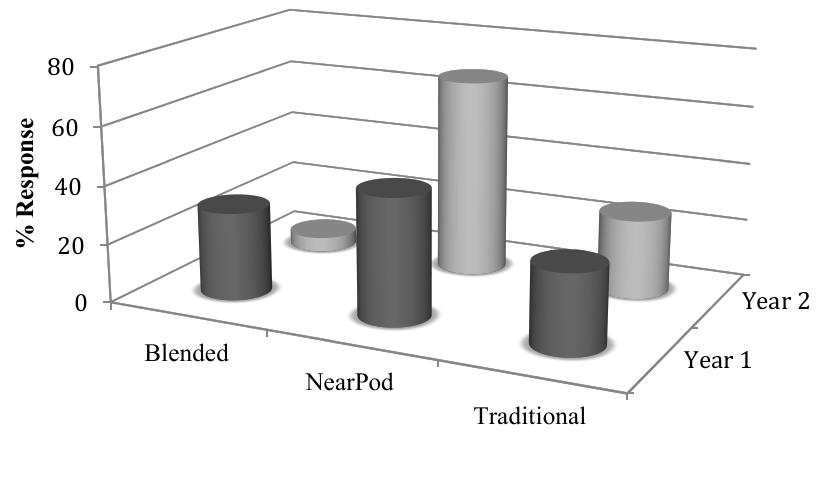
Figure 2: Comparative chart depicting the perceived most interactive class. Year one cohort (n=30), Year Two cohort (n=41); Trad = Traditional non-technology enhanced